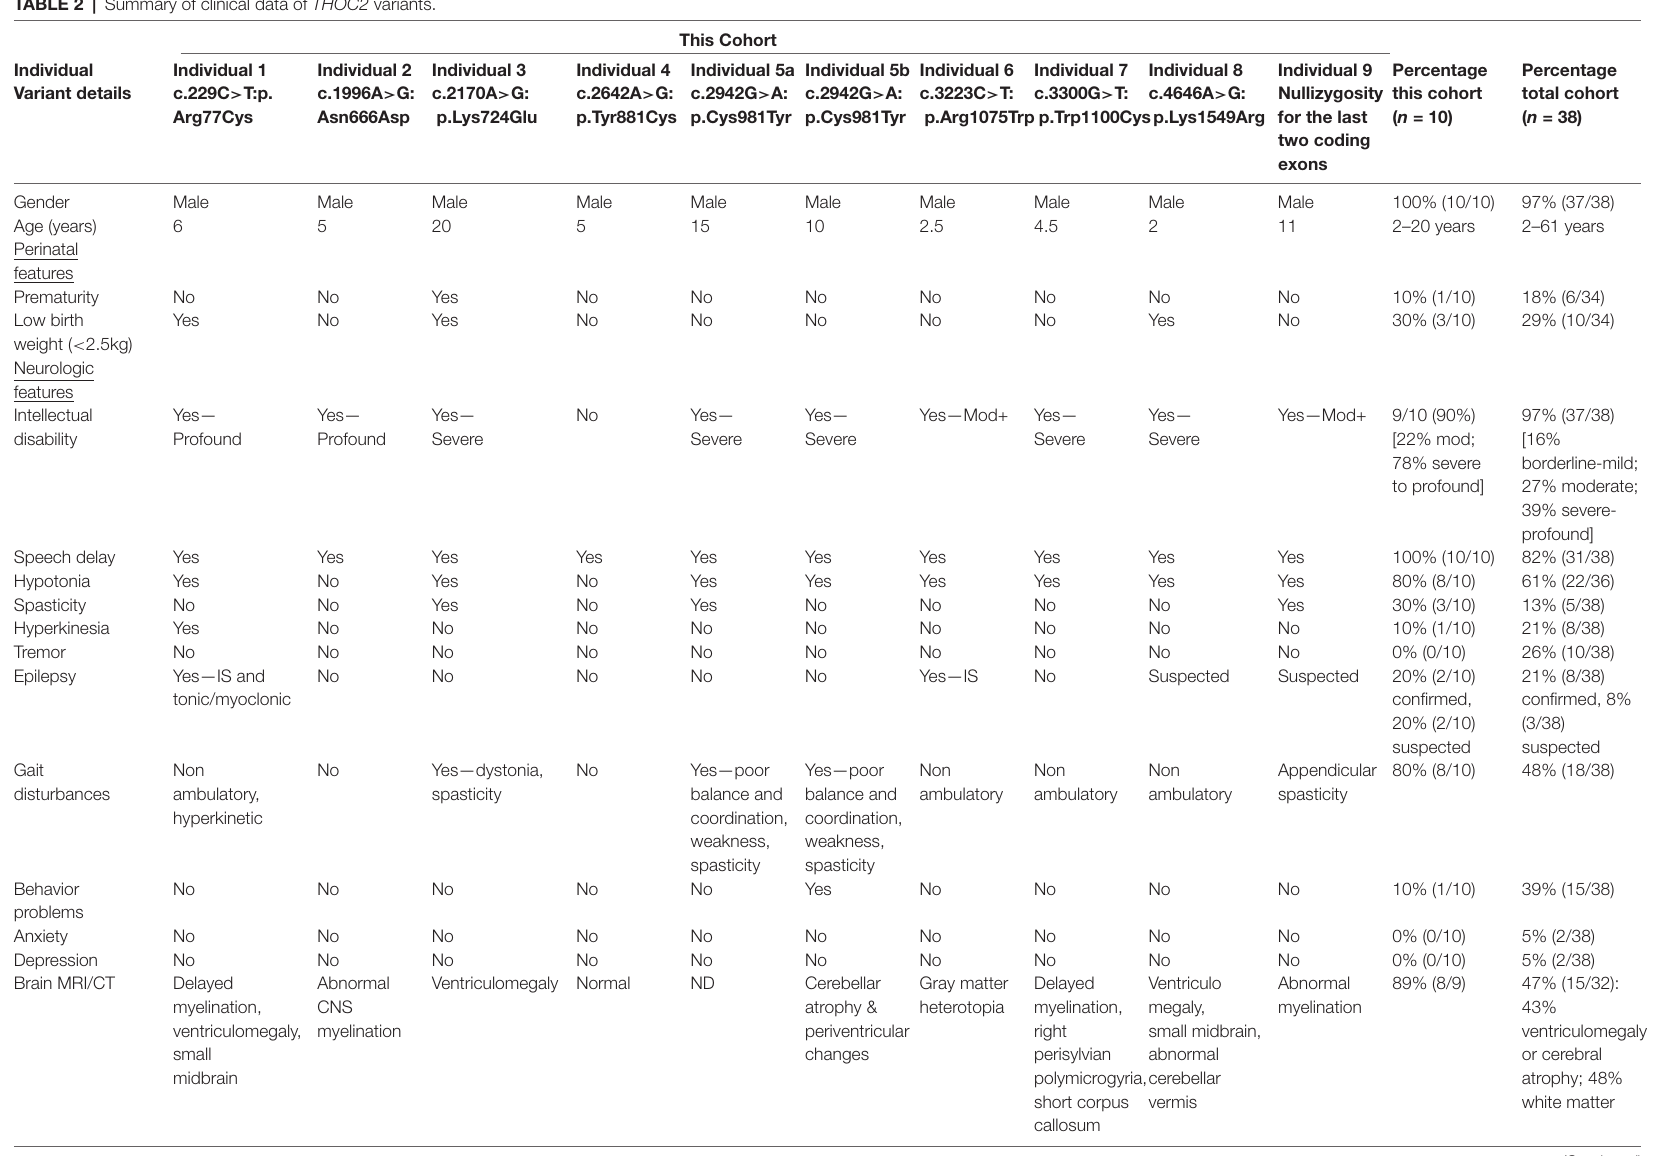
TABLE 2 | Summary of clinical data of THOC2